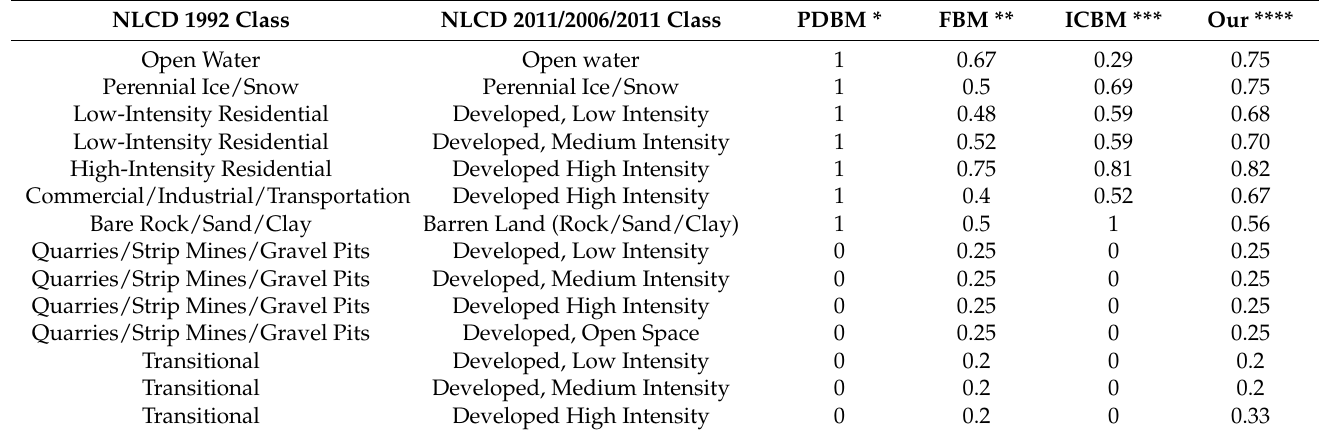
Table 5. Results of semantic similarity measuring between NLCD 1992 and NLCD